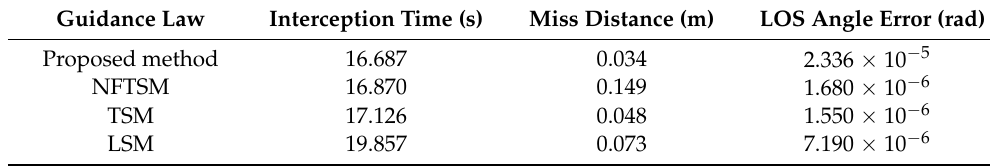
Table 8. Interception times, miss distances, and LOS angle errors of different guidance